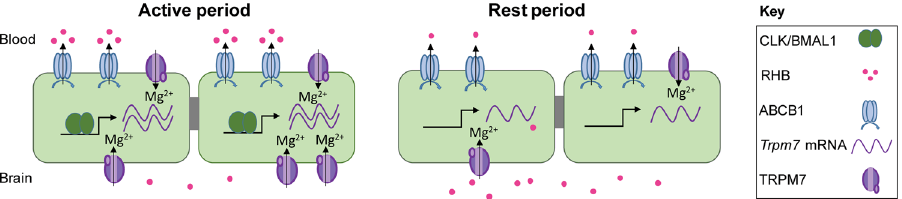
Fig. 7 Model of clock regulation of xenobiotic ef fl ux at the BBB. Core circadian clock transcription factors BMAL1 and CLOCK activate transcription of Trpm7 . Increased TRPM7 allows for higher intracellular free magnesium, which regulate the activity of xenobiotic transporters. Higher transporter activity decreases the level of xenobiotics in the brain. In the absence of BMAL1/CLOCK, TRPM7 and therefore free intracellular magnesium is low. Lower levels of magnesium are associated with decrease the activity of the xenobiotic transporters, thus xenobiotics are retained in the